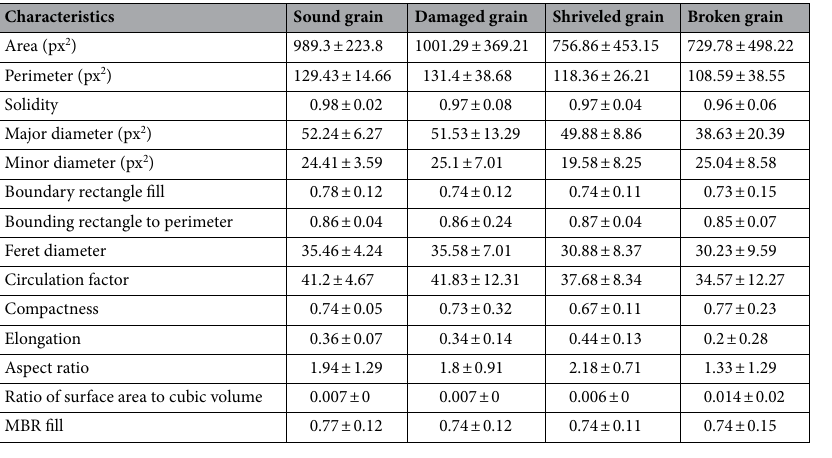
Table 7. Size and shape parameters derived from image to express the shape of selected wheat refractions.